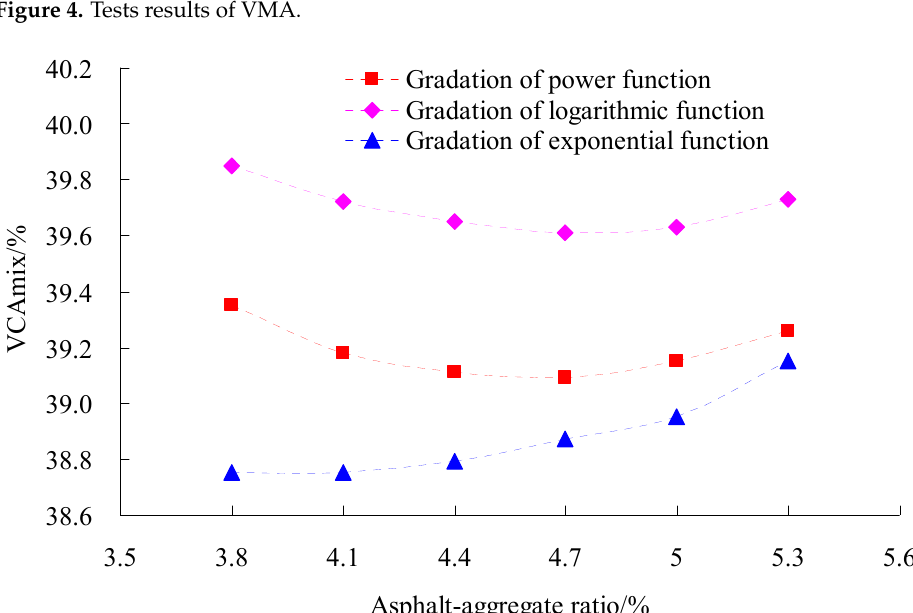
Figure 5. Tests results of VCAmix.